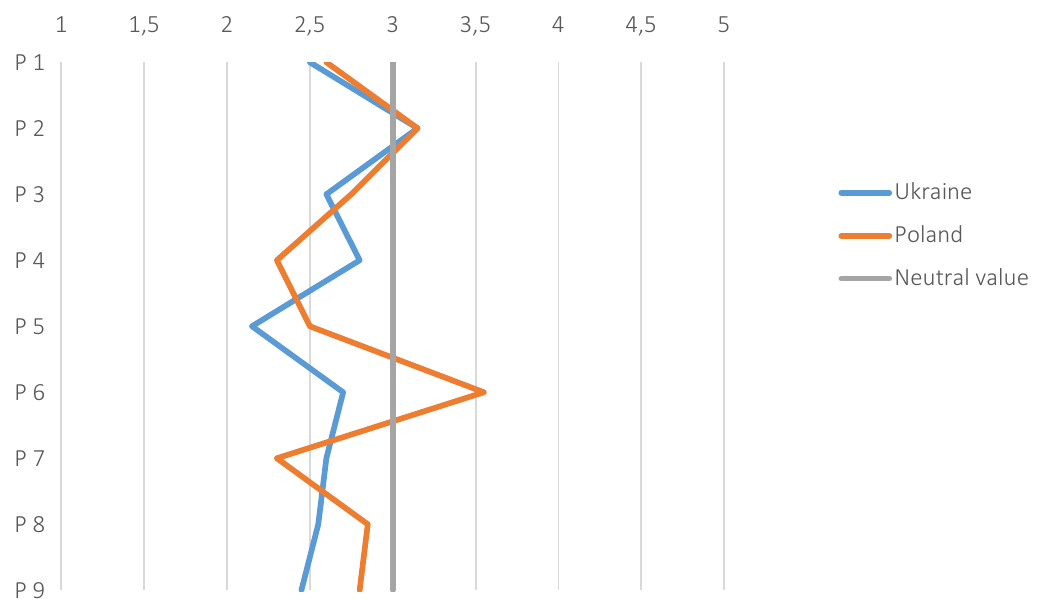
Figure 1. The attitudes of Polish and Ukrainian students towards the selected issues related to the pension system’s